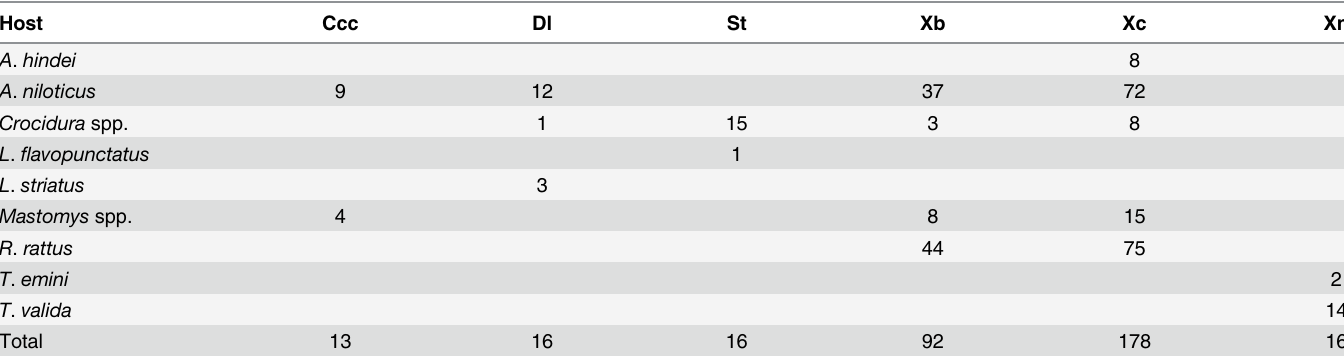
Table 2. Distribution of fleas across mammalian